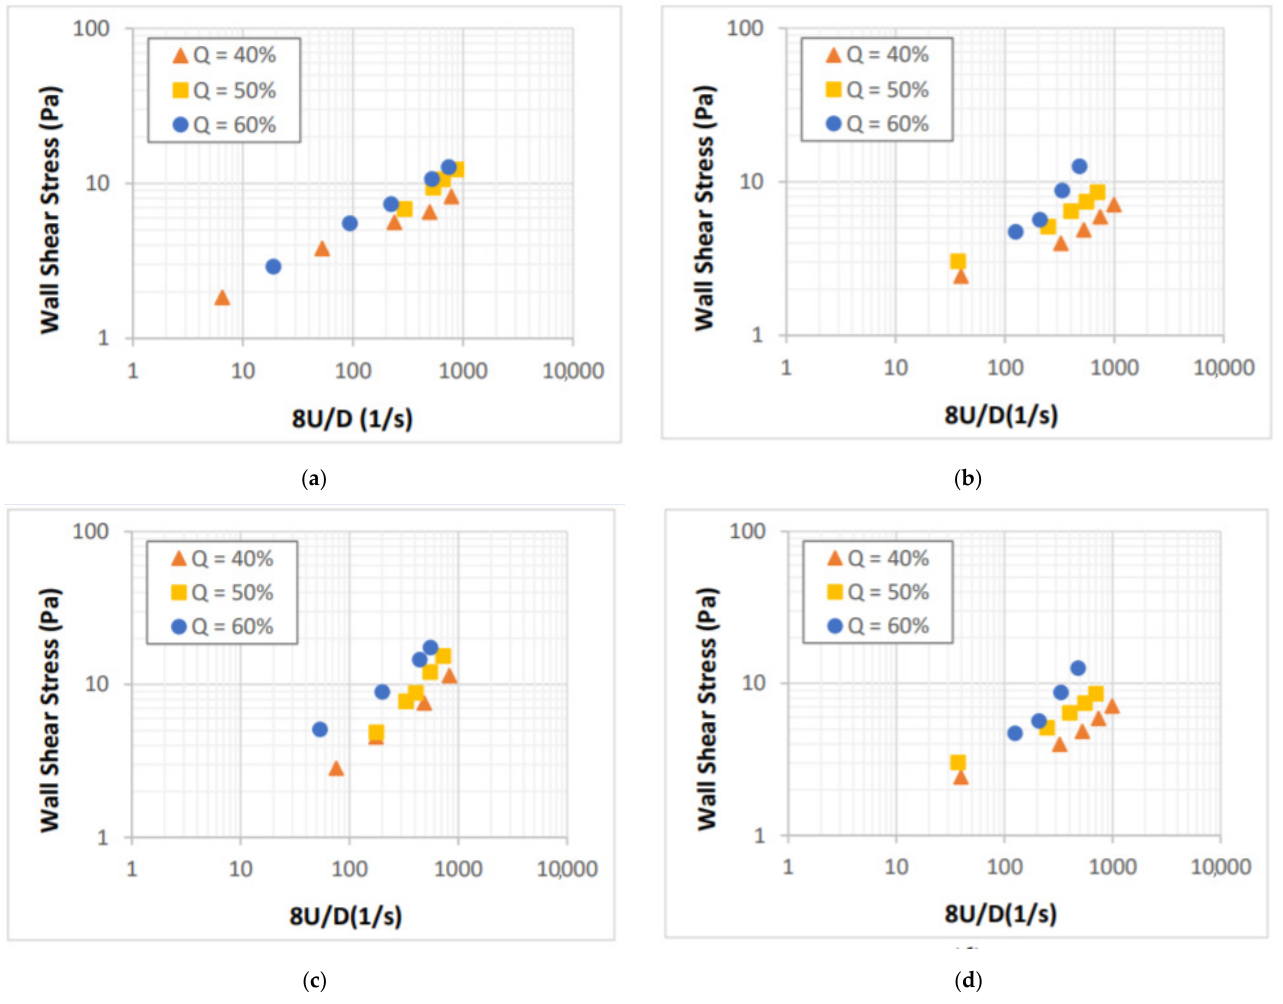
Figure 5. Shear stress vs. nominal Newtonian shear rate for: ( a ) 5%, ( b ) 9%, ( c ) 14%, and ( d ) 18% NaCl foams.